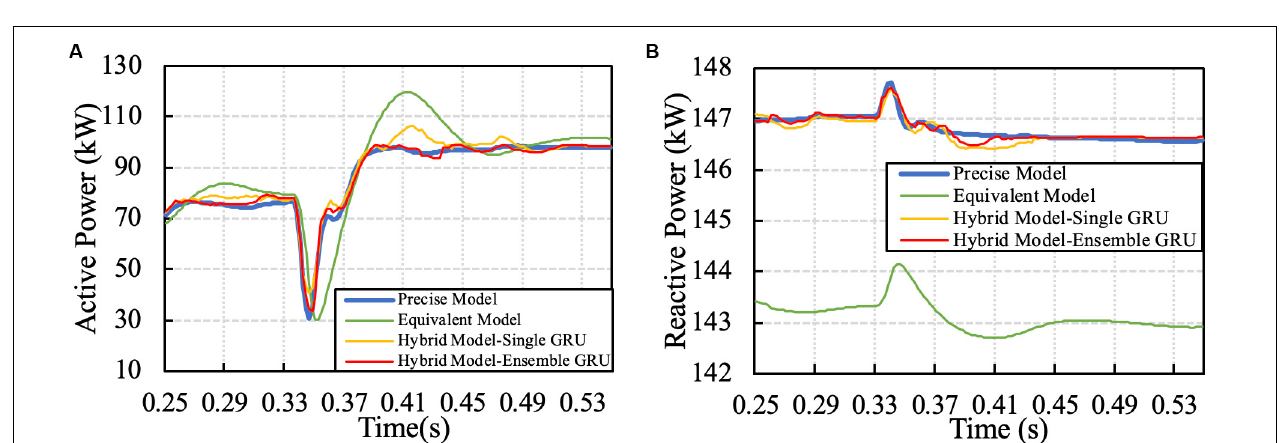
FIGURE 8 | Example of the response of precise, equivalent and hybrid model in Case I: (A) Active power, (B) Reactive power.